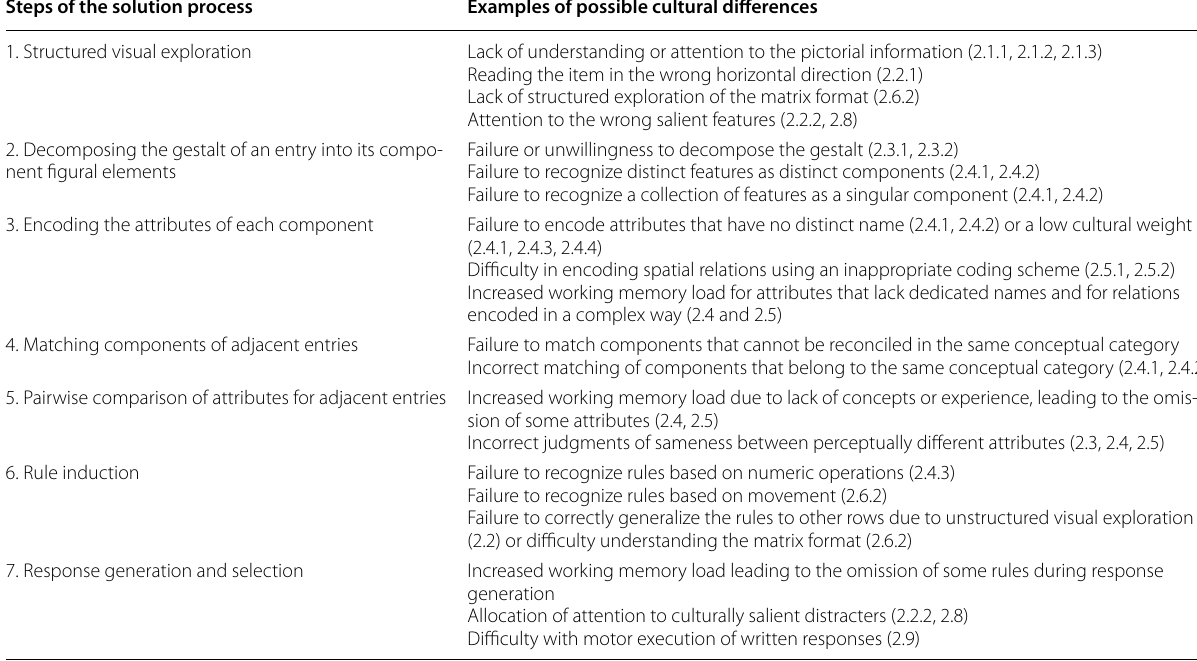
Numbers in parentheses in the rightmost column refer to section headings, as also listed in the leftmost column of Table